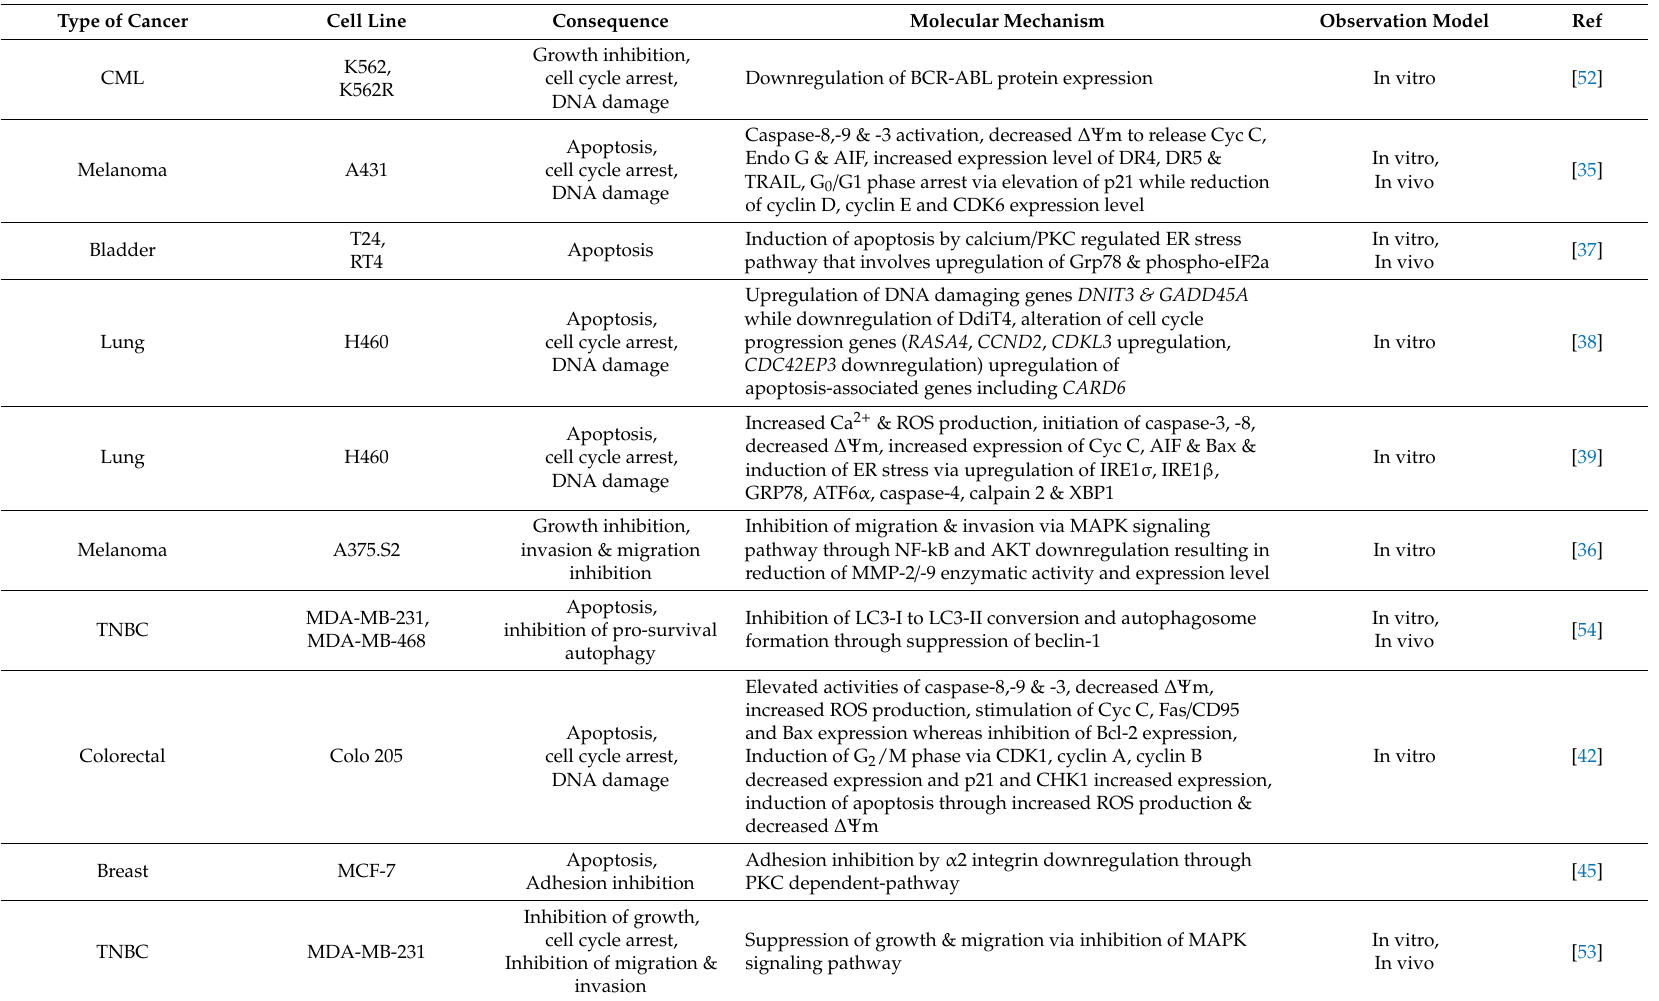
Table 1. Cantharidin (CTD) anticancer attributes and involved molecular